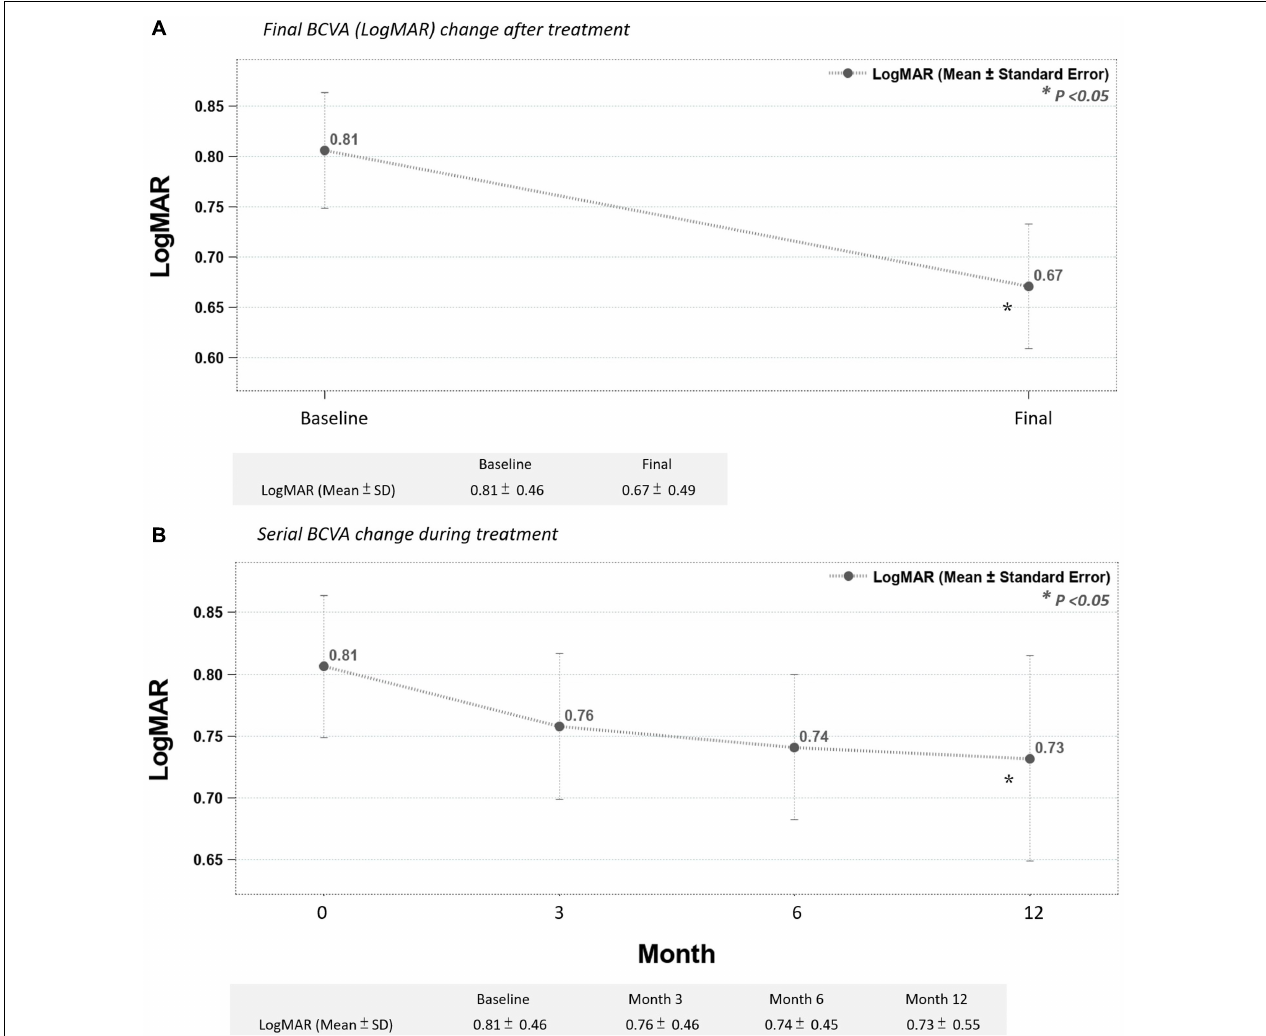
FIGURE 3 | (A) Final BCVA (LogMAR) significantly improved after treatment. (B) Mean BCVA improved gradually after the third month, reaching statistical significance in month 12 (* p < 0.05 compared to before-treatment